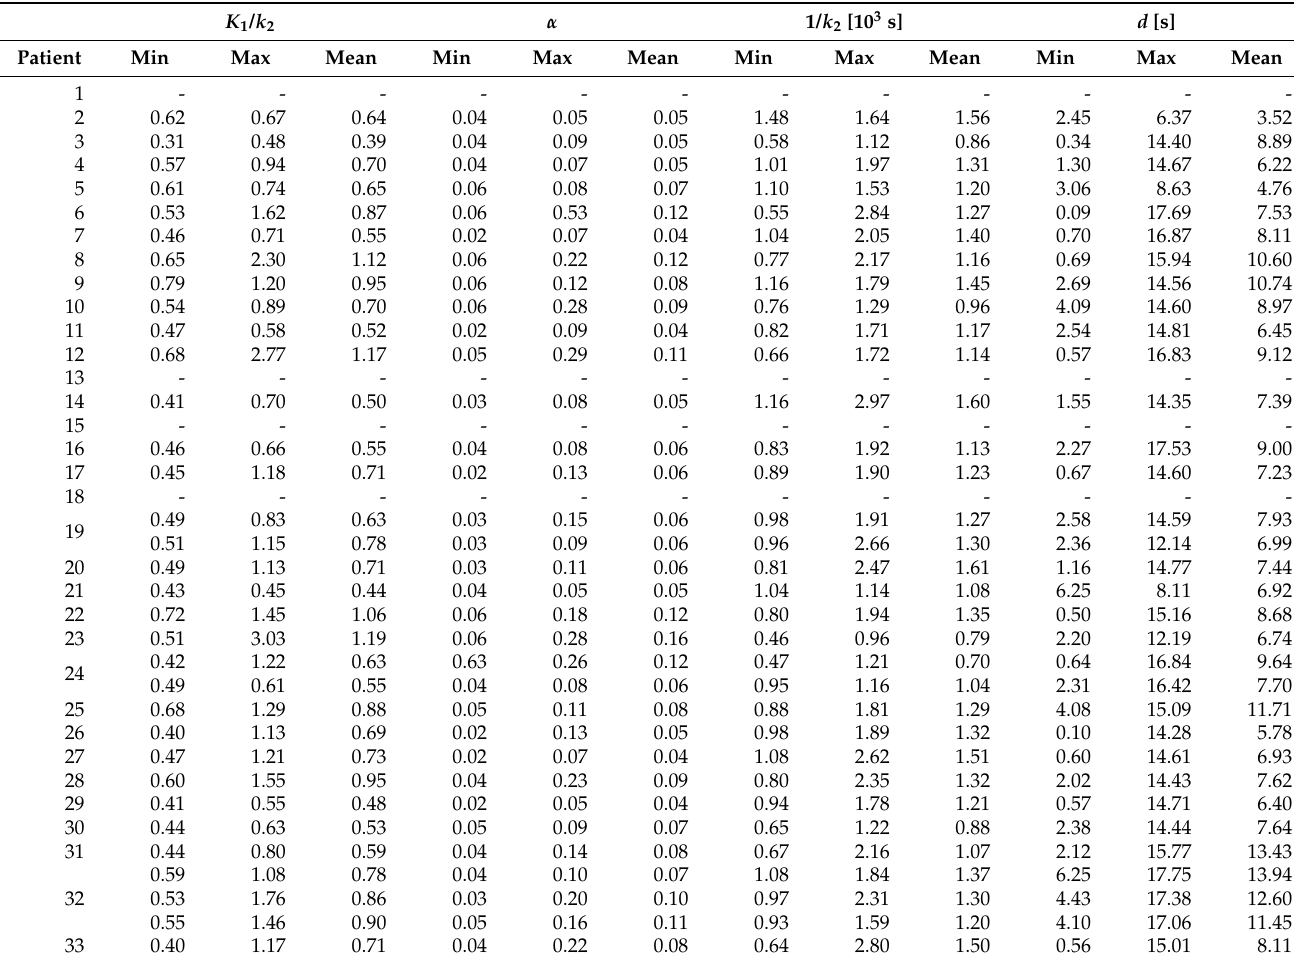
Table A4. Minimum, maximum, and mean 1TCM kinetic parameter values computed for each lesion within the